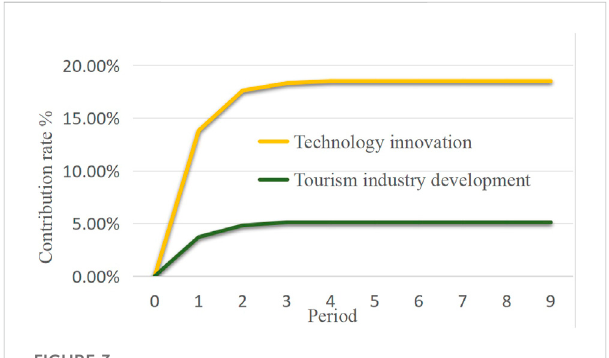
FIGURE 3 The trend of the contribution of tourism industry development and technological innovation to the promotion of